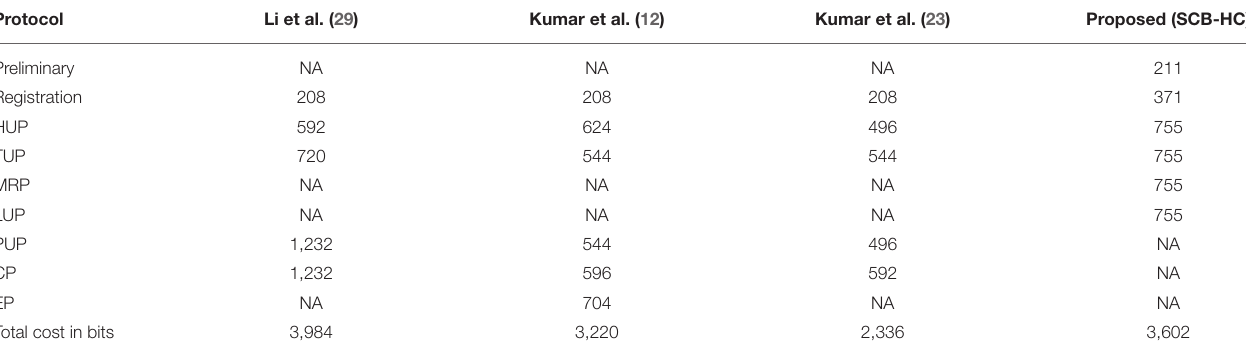
TABLE 5 | Communication cost comparison for SCB-HC with other related